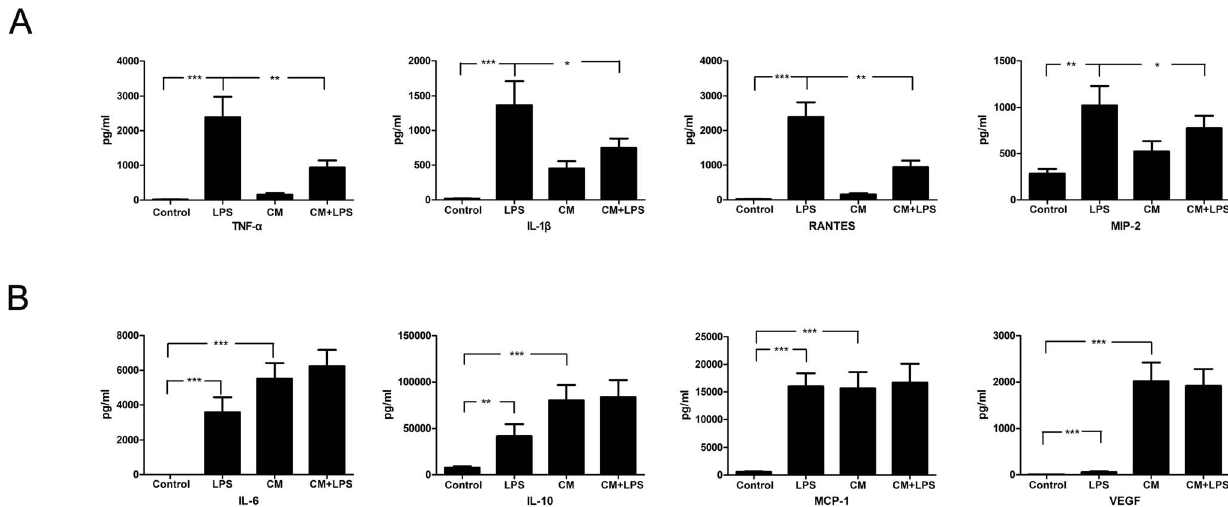
Figure 5. BMSCs alter LPS–induced upregulation of CD68 on microglia. Expression of CD11b and CD68 on microglia were assessed by cytofluorometric analysis. Cells were treated with DMEM/F-12 or conditioned medium with or without LPS and incubated for 48 hours. Red profiles represent expression of activating receptors; Blue profiles represent negative controls. Numbers indicate percentages of positive cells.